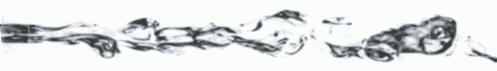
Visualization of a pheromone plume.The figure is extracted and adapted from a digitized image of a smoke plume filmed in a wind tunnel 1 m across and 2 m long with source on the left side [43]. Though the average pheromone concentration in the air decreases with distance, high pheromone concentrations can be found relatively far from the source due to the imperfect mixing of odorant with air. The signal detected by both moving and stationary detectors is therefore always intermittent, consisting of pulses of relatively undiluted pheromone.